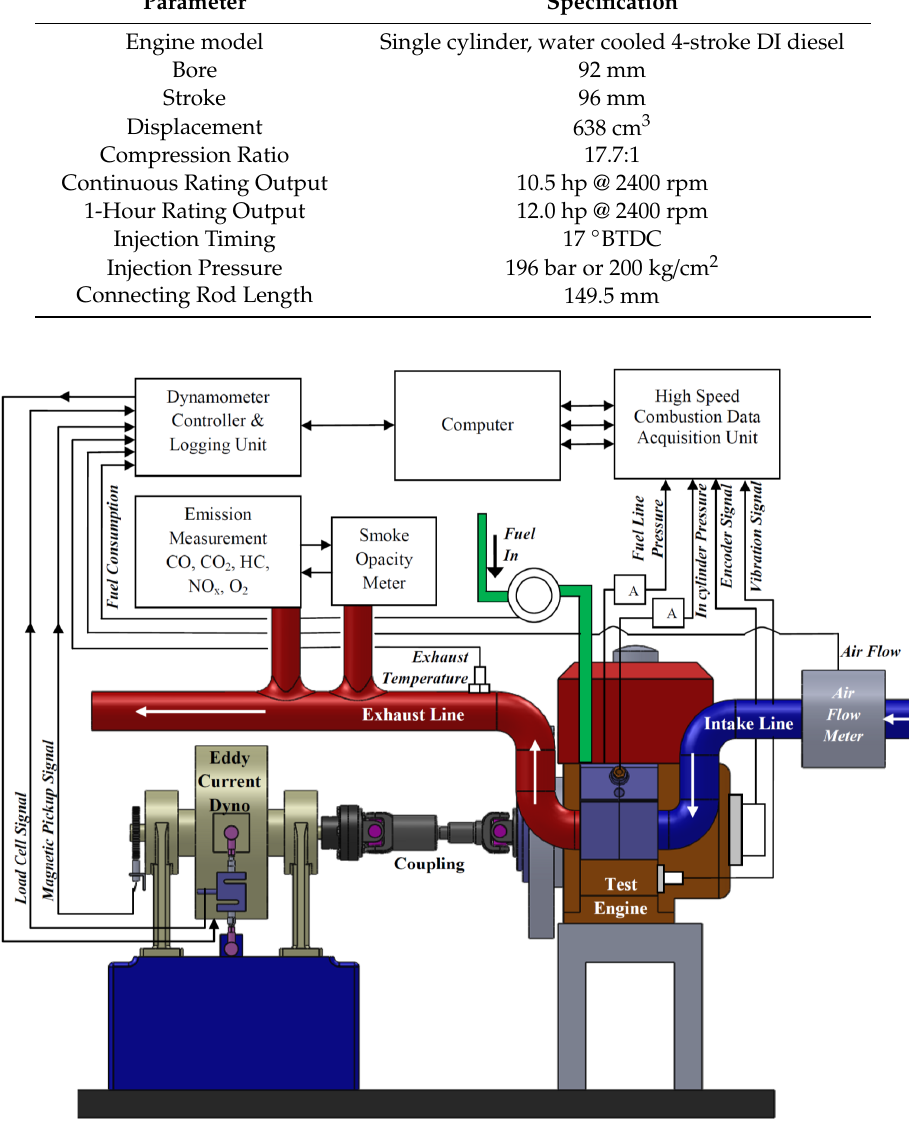
Figure 1. Schematic representation of the test rig. Note: “A” indicates the item is a charge amplifier.